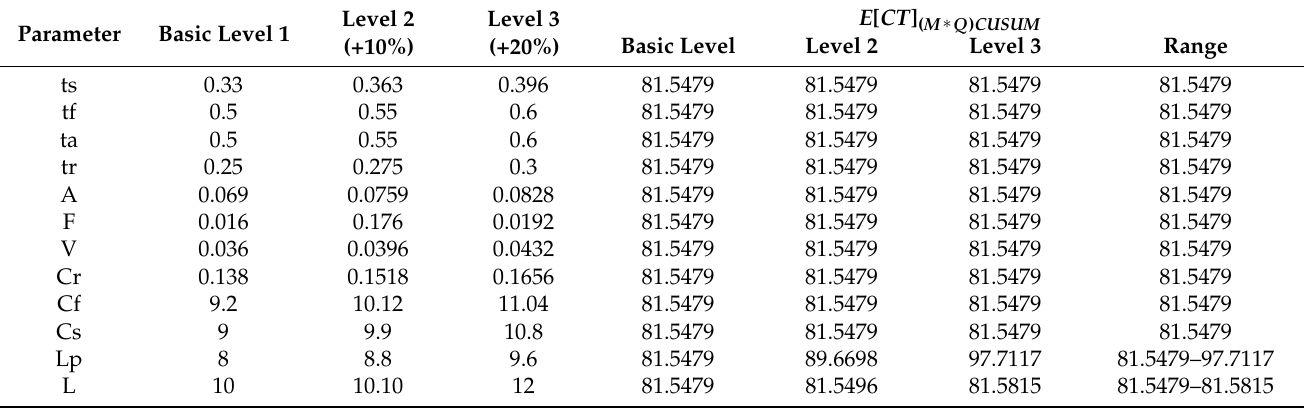
Results of the sensitivity analysis and influence range of the basic variables on E [ TC ] ( M ∗ Q ) CUSUM